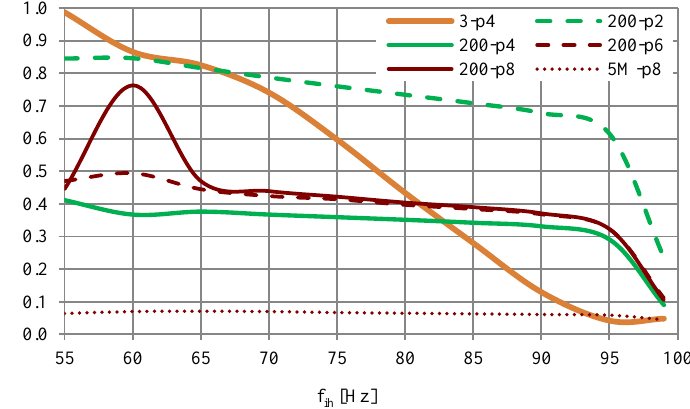
Figure 6. Computed current subharmonic vs. the frequency of voltage interharmonics for the various motors and the case of CRS.